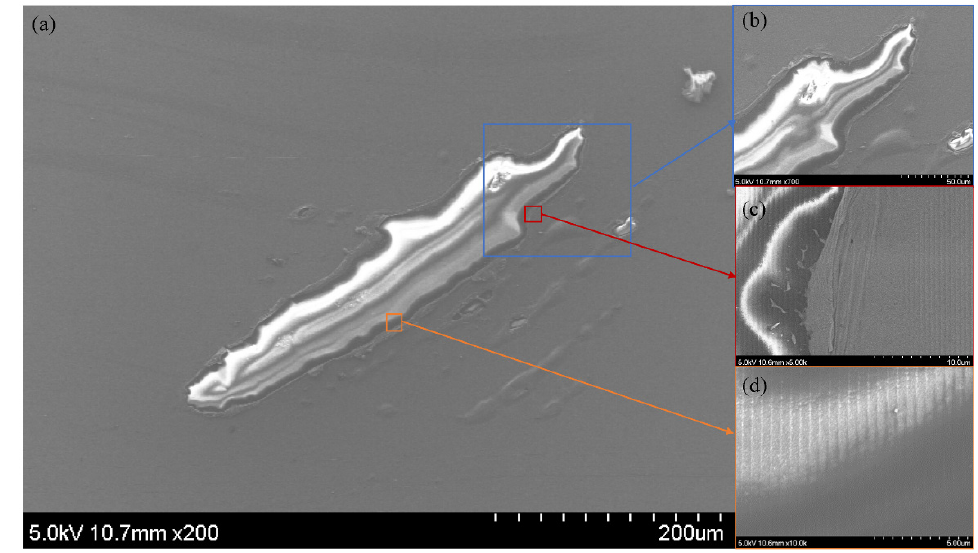
Figure 6. Thermodynamic damage morphology of ACGs at 0.72 J/cm 2 .